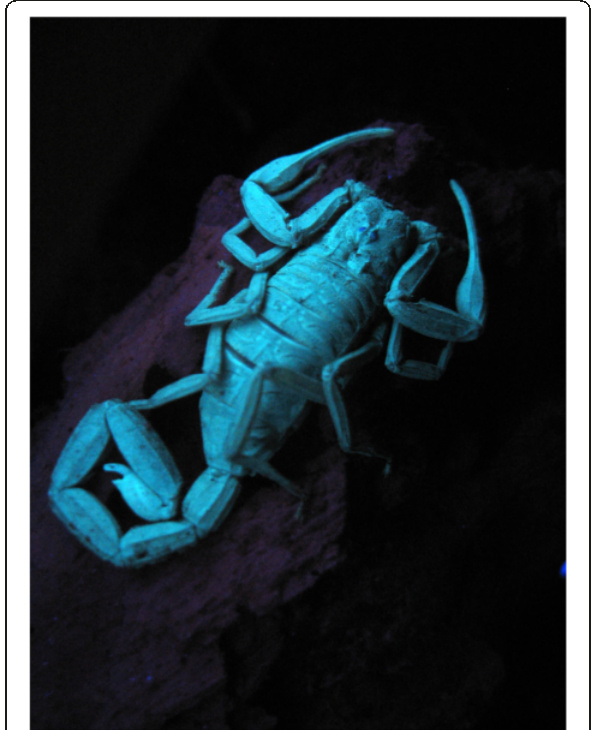
Fig. 1 Tityus brazilae Lourenço & Eickstedt, 1984; female from